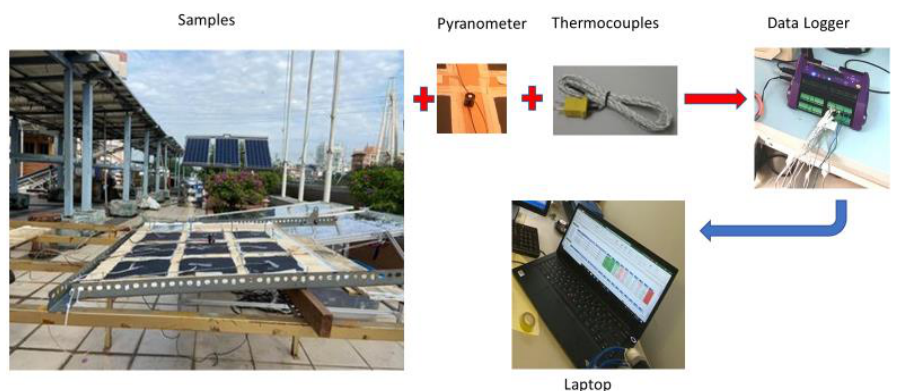
Figure 3. Outdoor experimental setup.